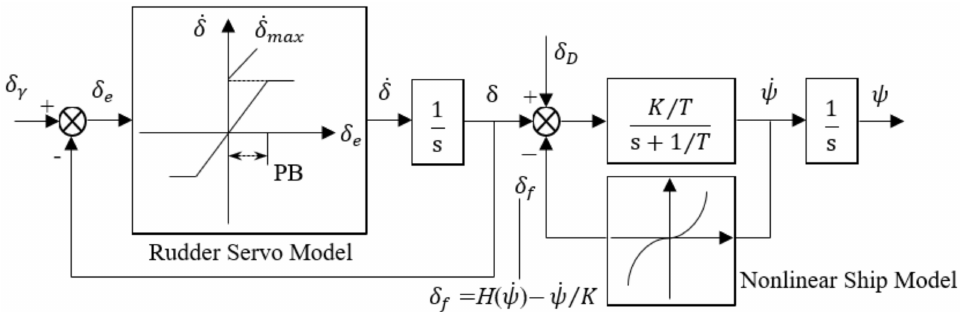
Figure 2. Responding nonlinear ship